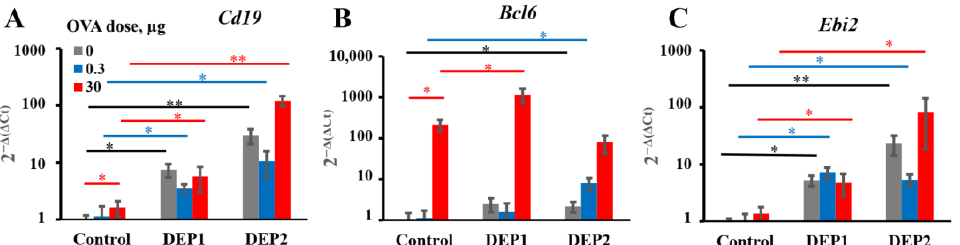
Figure 7. Expression of B-cell-related genes in lung tissue. BALB/c mice were immunized as described in Figure 4 with or without high (150 µ g) DEPs doses. Control mice were immunized in the absence of DEPs. Expression of markers for relative B-cell numbers (Cd19; ( A )), germinal center formation (Bcl6; ( B )), and B-cell extrafollicular activation (Ebi2; ( C )) is shown. Black bars indicate significant (*— p < 0.05; **— p < 0.01) differences between the mice immunized without OVA with different DEPs and the respective control without DEPs; green bars indicate significant differences between the mice immunized with low OVA doses with or without DEPs and the respective control groups; red bars indicate significant differences between the mice immunized with high OVA doses with or without DEPs and the respective control groups. The experiment was performed three times. The graphs show the data from three representative experiments (total number of mice included in analysis from all experiments n = 6 per group). The data indicate biological replicates obtained from individual mice.